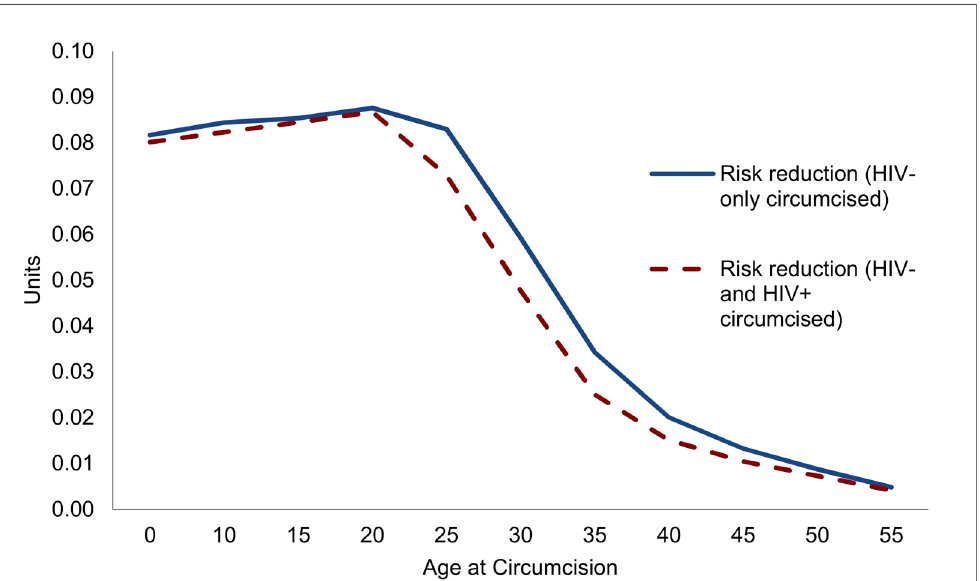
Fig 2. Reduction in lifetime risk of contracting HIV for individual circumcised, by age at circumcision (units).